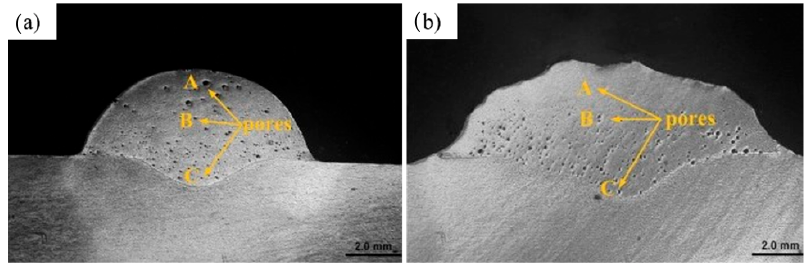
Figure 9. SEM of weld bead of CMT welded 6062 aluminum alloy ( a ) without UIP; ( b ) with UIP. Reproduced with permission from [85]. Copyright Elsevier,